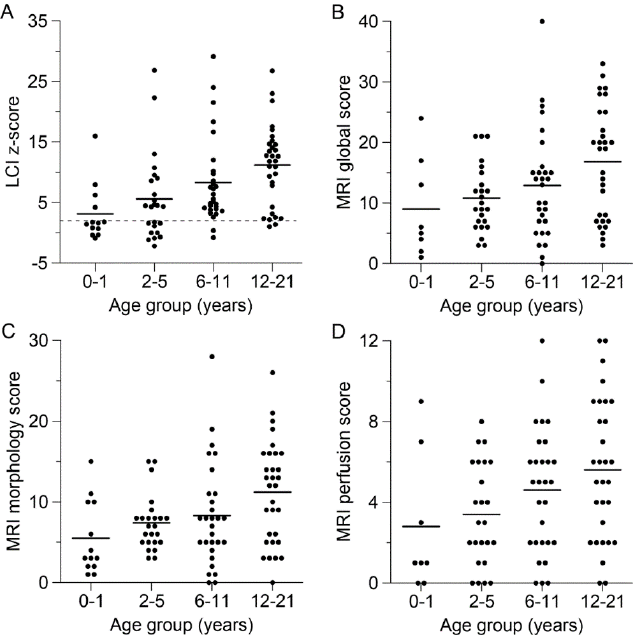
Figure 1. Variability of lung disease in children and adolescents with cystic fibrosis (CF) across the pediatric age range. ( A – D ) Level of lung disease in individual patients with CF determined by multiple-breath washout (MBW) and morpho-functional lung magnetic resonance imaging (MRI). Results are displayed for the lung clearance index (LCI) z -scores derived from age-adapted MBW using either sulfur hexafluoride (infants and toddlers) or nitrogen (children 4 years and older) as tracer gas ( A ), and the MRI global score ( B ), morphology score ( C ) and perfusion score ( D ). The solid lines indicate the mean of each age group, and the dashed line in panel A indicates the upper limit of normal for the LCI z -score (+1.96 SD). Perfusion studies were performed in 91 of 97 children with CF. Adapted from [31]. Adapted with permission of the American Thoracic Society. Copyright © 2021 American Thoracic Society. All rights